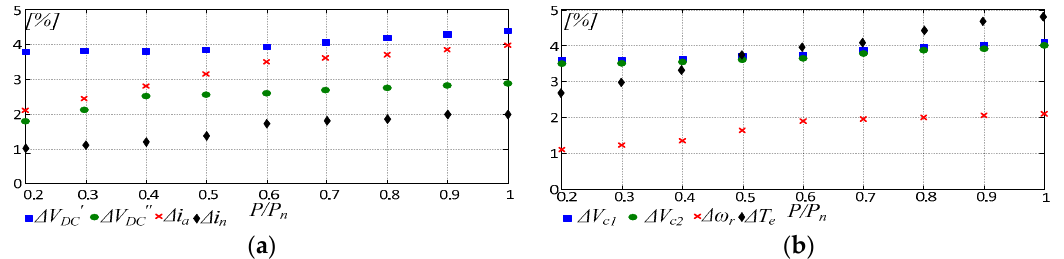
Figure 21. Percentage error between SymPower System and averaged model vs. the power expressed in per unit P/P n . ( a ) Errors of V DC ' , V DC '', i a , and i n . ( b ) Errors of V c1 , V c2 , ω r and T e . Note: ω r = 200 rad/s, V DC ' = 400 V, and V DC '' = 100 V.